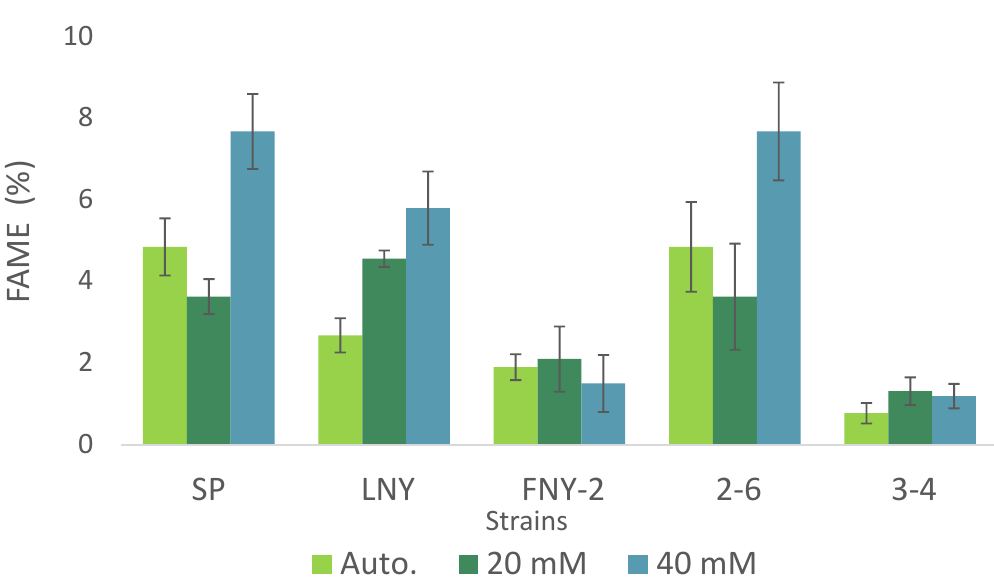
Figure 4. Accumulation of FAME in algal strains grown under autotrophic conditions and heterotrophic conditions with 20 or 40 mM glycerol. Means ± SE, n = 3.